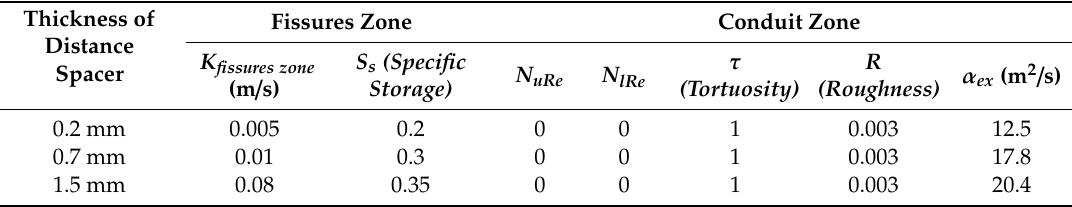
Figure 5. Comparison of calculated and observed hydraulic head variations for scenario B using parameter values shown in Table 1. Table 2. Values of model parameters adopted in the laboratory-scale numerical simulations. ( N uRe and N lRe are upper and lower critical Reynolds number, respectively).